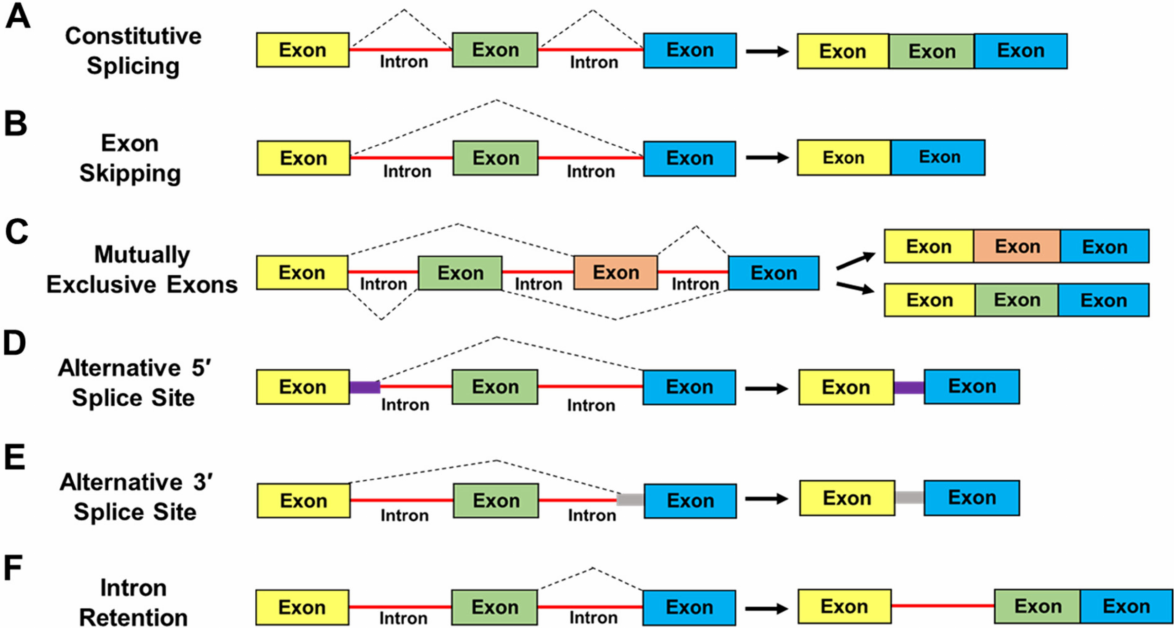
Figure 2. Schematic representation of classical mechanisms of alternative splicing. The figure displays different classes of alternative mRNA processing events and examples of alternatively spliced products [36–38,44]. ( A ) Constitutive Splicing; ( B ) Exon Skipping; ( C ) Mutually Exclusive Exons; ( D ) Alternative 5 (cid:48) Splice site; ( E ) Alternative 3 (cid:48) Splice site; ( F ) Intron Retention. Further information regarding each class of alternative splicing events is given in the